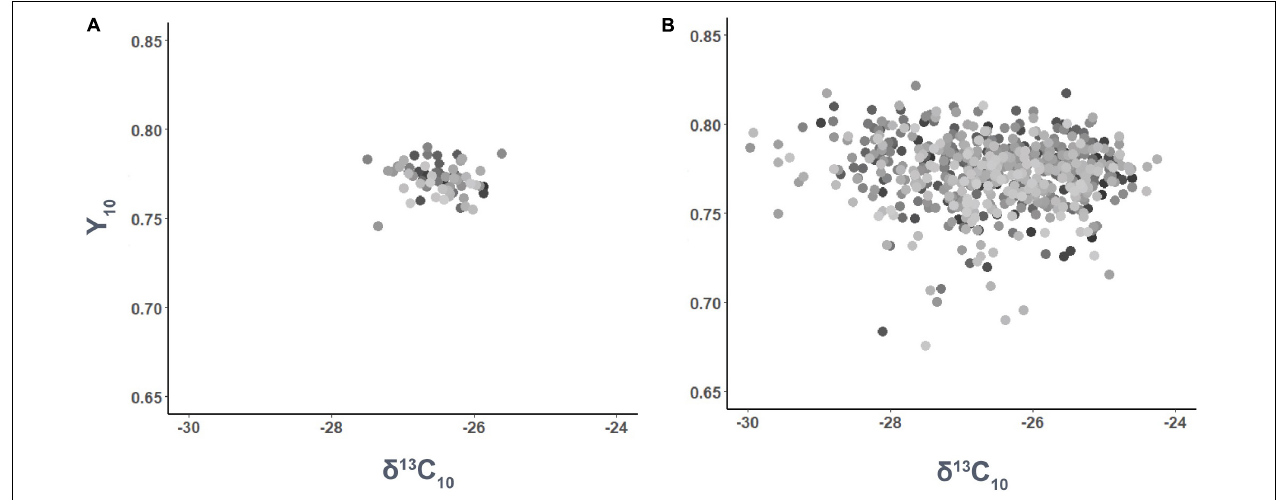
FIGURE 3 | Phenotypic relationship between needle carbon isotope composition ( δ 13 C 10 ) and maximum quantum yield of PSII (Y 10 ) after 10 months of water stress by family (A) and genotype (B) .